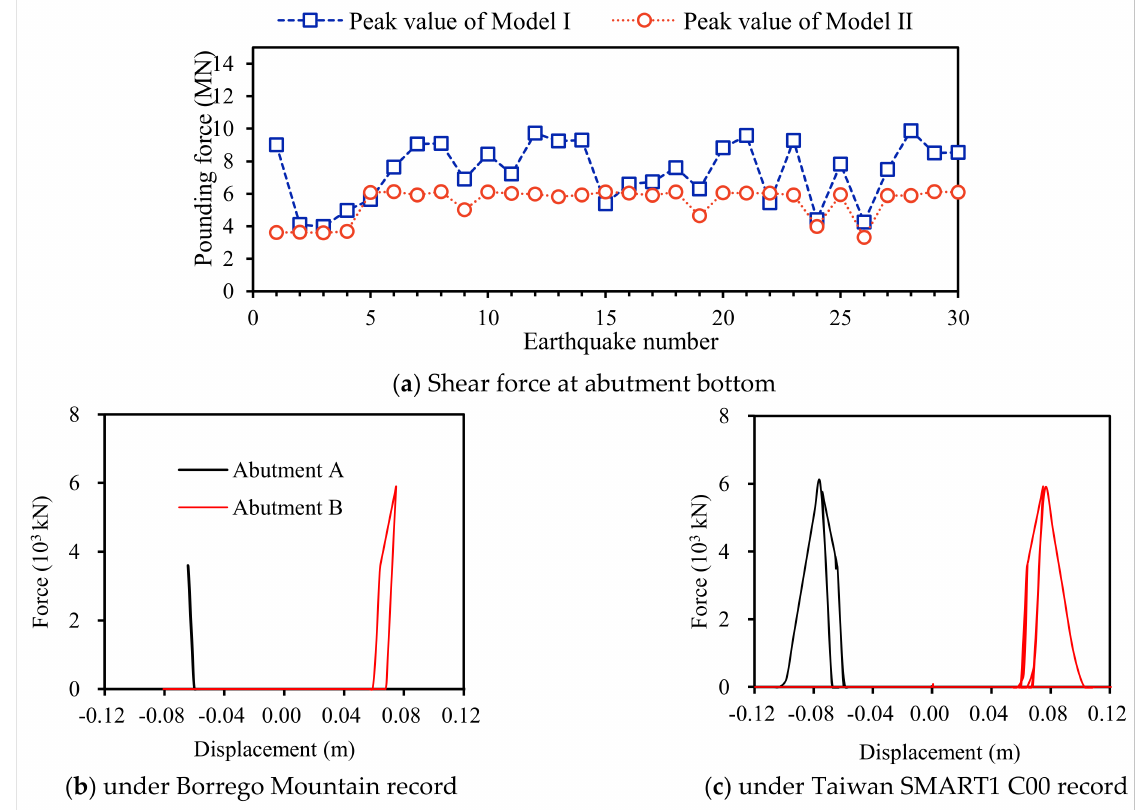
Figure 10. Abutment backwall